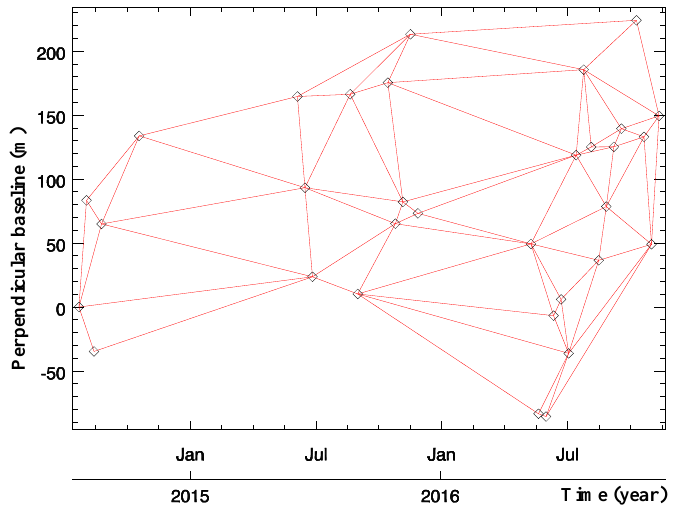
Figure 4. The spatial and temporal baseline distributions of the TerraSAR-X data generated interferograms over the study area. The black diamonds and red lines denote the SAR images and interferograms,